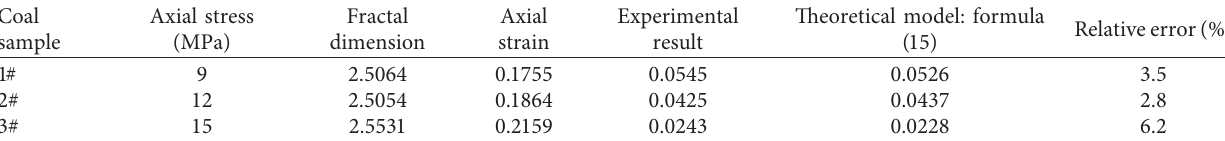
Table 5: The results of the fractal porosity of the compacted broken